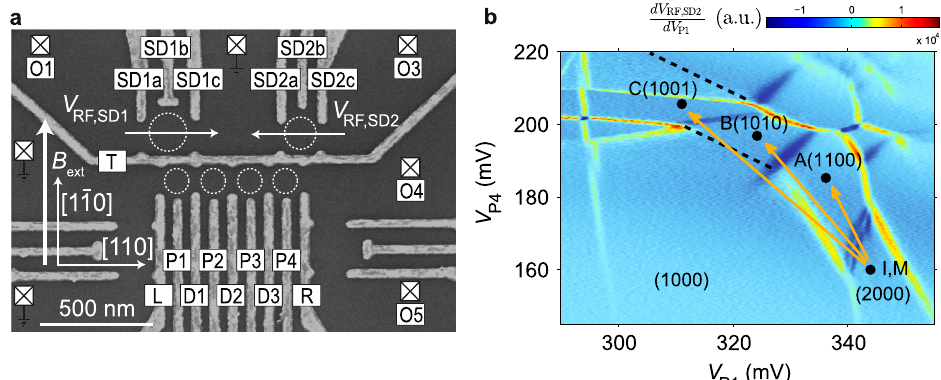
Fig. 1 Device image and spin shuttling protocol. a Scanning electron microscope image of a sample nominally identical to the one used for the measurements. Dotted circles indicate the intended quantum dot positions and squares indicate Fermi reservoirs in the 2DEG, which are connected to ohmic contacts. The RF re fl ectance of SD1 and/or SD2 are monitored in order to determine the occupancies of the four dots in the linear array.(Reproduced from ref. 10, with the permission of AIP Publishing) b Charge stability diagram that includes the regions with two electrons involved in the shuttling sequence. Horizontal traces are averaged over 200 sweeps with a scan rate of 4.4 ms per sweep. The (1010) (or (1100)) region fading into the (1000) region occurs due to the slow unloading of the electron in dot 3 (or dot 2) relative to the scan rate. Labels indicate the number of electrons on each of the four dots. The dot array is initialized with two electrons on the leftmost dot, allowing them to relax to the spin-singlet ground state (point I). Then, a gate voltage pulse takes the system to point A, B, or C, resulting in the transfer of one of the two electrons to the second, third, or fourth dot, respectively. After the gate voltage pulse, the system returns to point (M), and the spin state is measured using Pauli spin blockade. We infer a spin-singlet (triplet) state when the signal of SD1 reads (2000) ((1100)) for an integration time of 5 μ s. The data shown here was chosen since it clearly shows all the relevant charge transitions. The corresponding data with the settings used in Fig. 3 is shown in Supplementary Information Section